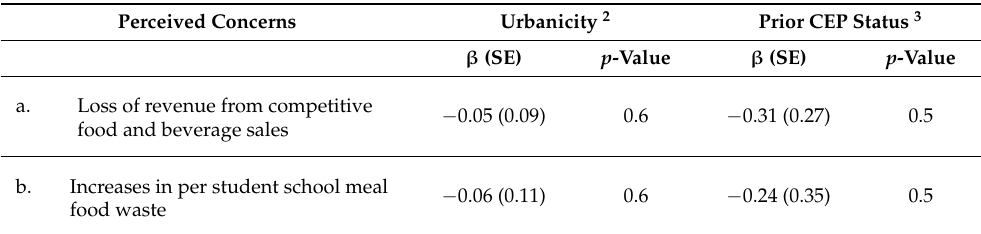
Table 3. Differences in Concerns Regarding Anticipated Future Challenges among School Food Authorities in Maine by urbanicity and prior CEP status 1 ( n =